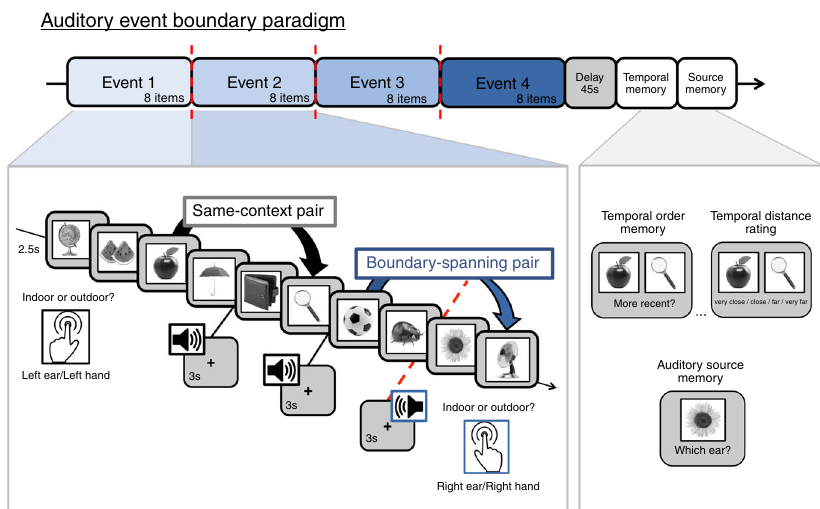
Fig. 1 Auditory event boundary paradigm. Participants studied lists of 32 everyday objects and had to indicate whether each item would more likely be encountered in an indoor or outdoor setting. The surrounding context was manipulated by playing a simple tone in either participants ’ left or right ear prior to viewing each image, which indicated to participants which hand they should use to make their subsequent indoor/outdoor judgment. After eight successive items, the tone switched to the other ear and changed in pitch. These tone switches served as event boundaries, which parsed each continuous 32-item sequence into four discrete auditory events. After a short distractor task, participants performed three different memory tests in two separate blocks of trials: the fi rst block included two different temporal memory tests and the second block included a source memory test. In the temporal memory block, participants fi rst had to indicate which of the two presented items had appeared more recently in the prior sequence. Second, they had to rate the temporal distance between these items, ranging from ‘ very close ’ to ‘ very far ’ apart in the sequence. After being tested on item pairs, participants performed an auditory source memory test for all of the remaining items that were not shown during the temporal memory tests. In this source memory test, participants were shown individual items and had to indicate whether each item had been paired with a tone in their left ear or their right ear. The hand button-press icon was made by Freepik from www. fl